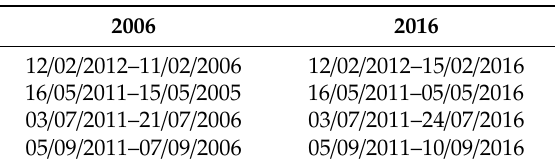
Table 3. List of image